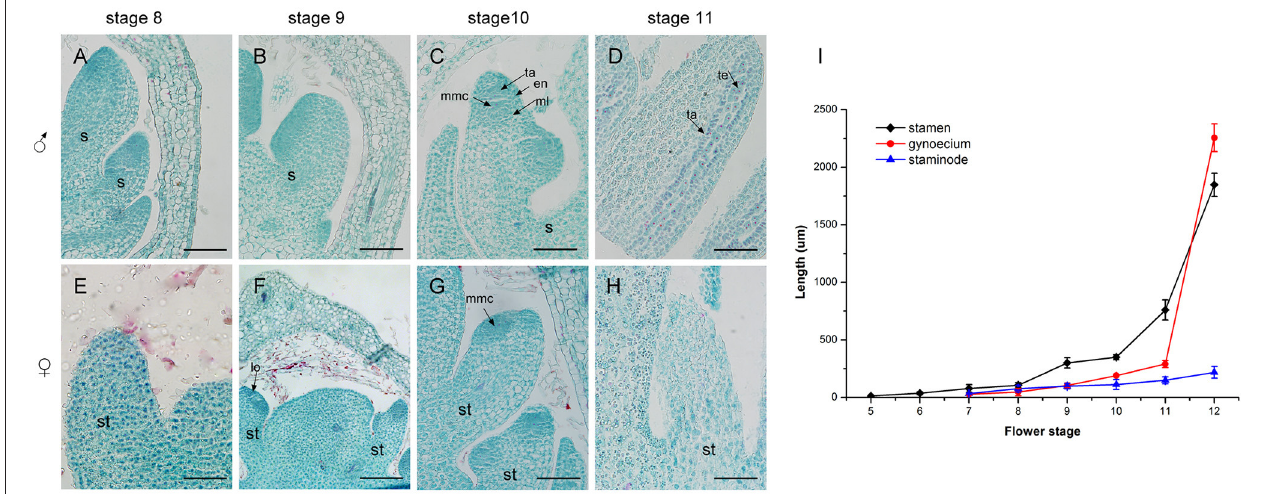
FIGURE 6 | Development of the androecium (A–H) and length of flower organs (I) in male and female flowers. (A) Stamen development at stage 8. (B) Appearance of anther and filament at stage 9. (C) Meiosis division occurred in locules of the anther at stage 10. (D) More pollen grains were surrounded by tapetum at stage 11. (E,F) Stage 8 and 9, respectively: the growth of staminode primordium was the same as in stages (A,B) . (G) At stage 10, staminode development was blocked. (H) The staminode cells became vacuolated with sparse cytoplasm density. s, stamen; ta, tapetum; en, endothecium; ml, middle layer; lo, locule; te, tetrad; st, staminode; mmc, microspore mother cell. Scale bar = 100 um.